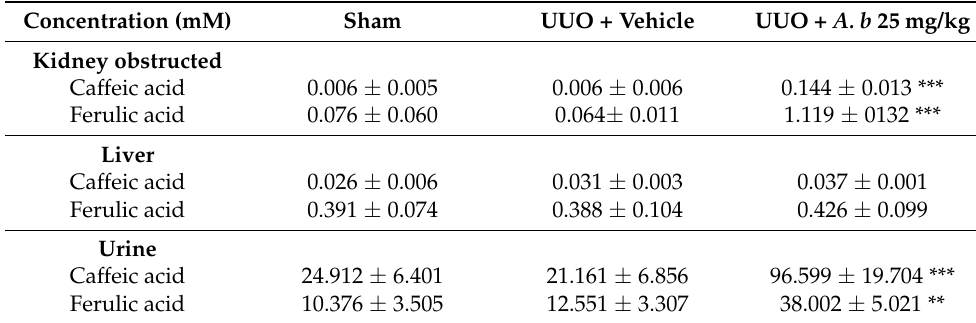
Table 3. Distribution of caffeic acid (CA) and its methylated metabolite, ferulic acid (FA), in obstructed kidney, liver and urine after ingestion of 25 mg/kg of A. borbonica ( A. b ). The concentrations were measured by UPLC-HESI-Q-Orbitrap (Q-Exactive™ Plus) and expressed in ( µ M). ** p < 0.01, *** p < 0.001, compared to UUO + Vehicle. Values are means ± SD; n = 7 animals/group. Concentration (mM) Sham UUO + Vehicle UUO + A. b 25 mg/kg Kidney obstructed Caffeic acid 0.006 ± 0.005 0.006 ± 0.006 0.144 ± 0.013 *** Ferulic acid 0.076 ± 0.060 Caffeic acid 0.026 ±